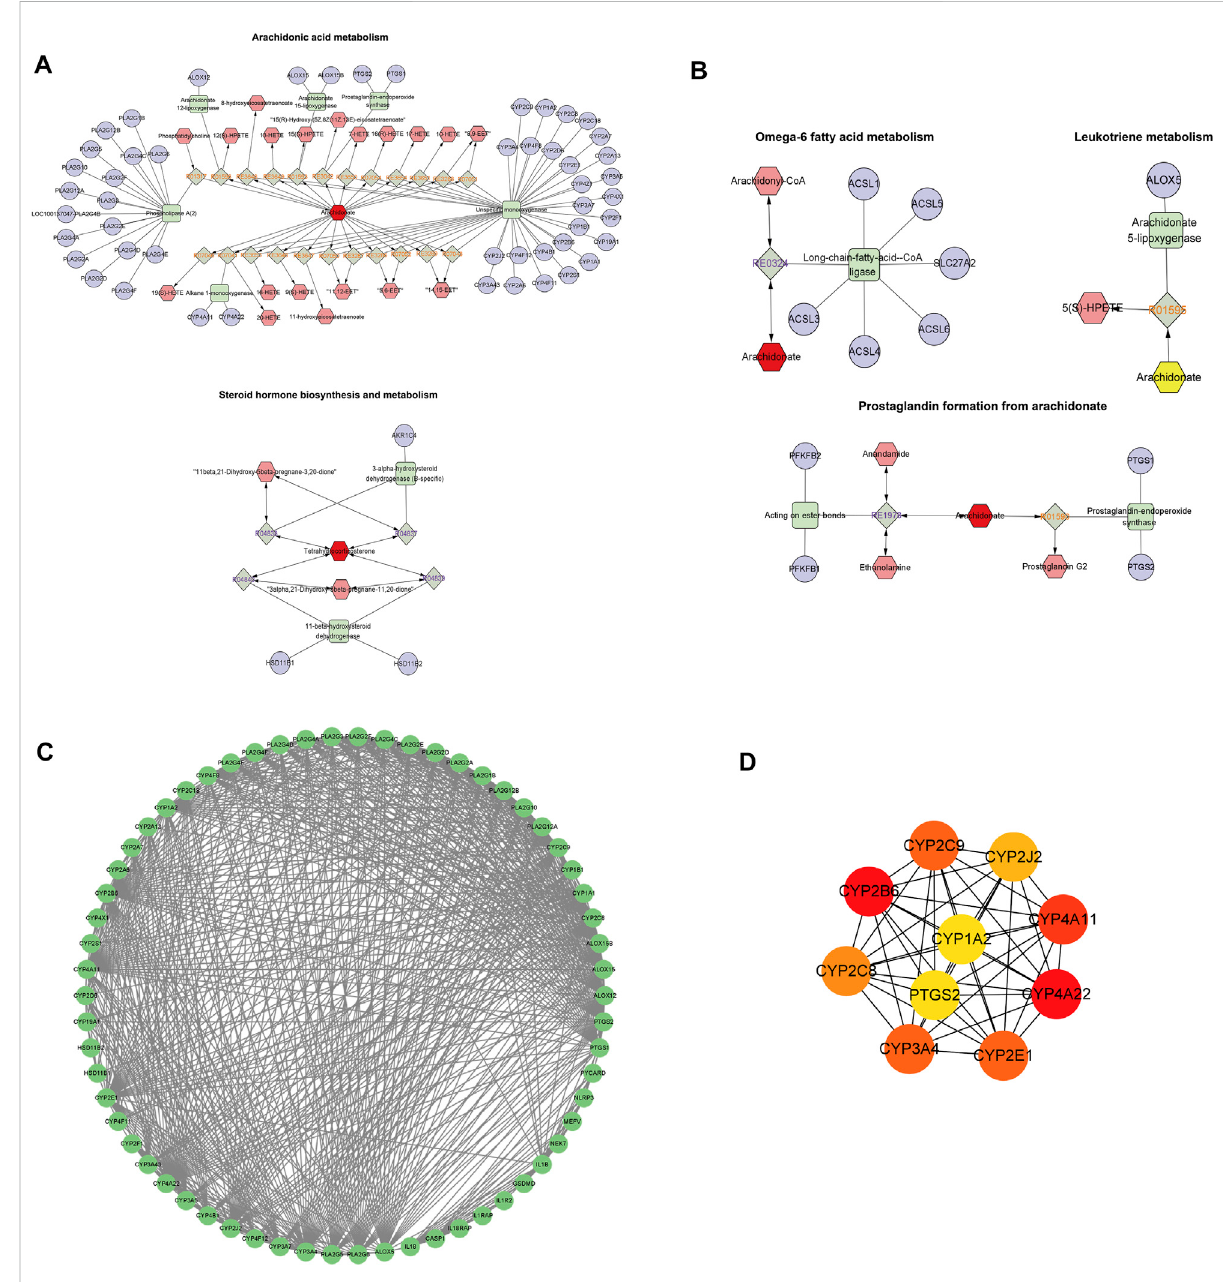
FIGURE 8 Core genetic screening for the interaction of metabolic biomarkers and pyroptosis. (A,B) Compound-Reaction-Enzyme-Gene network day. (A) : Arachidonic acid metabolism and steroid hormone biosynthesis and metabolism; (B) : Leukotriene metabolism, omega-6 fatty acid metabolism, and prostaglandin formation from arachidonic acid. Green squares: metabolic enzymes; purple circles: genes; red hexagons: metabolites; gray diamonds: enzymatic reactions; orange hexagons: compounds. (C) : Protein-protein interaction (PPI) network diagram of 63 metabolite- relatedgenesand6pyroptosis-relatedgenes. (D) :Coregenes.Fromredtoyellow:Thedarkerthecolor,thegreaterthedegreevalueandthegreater the